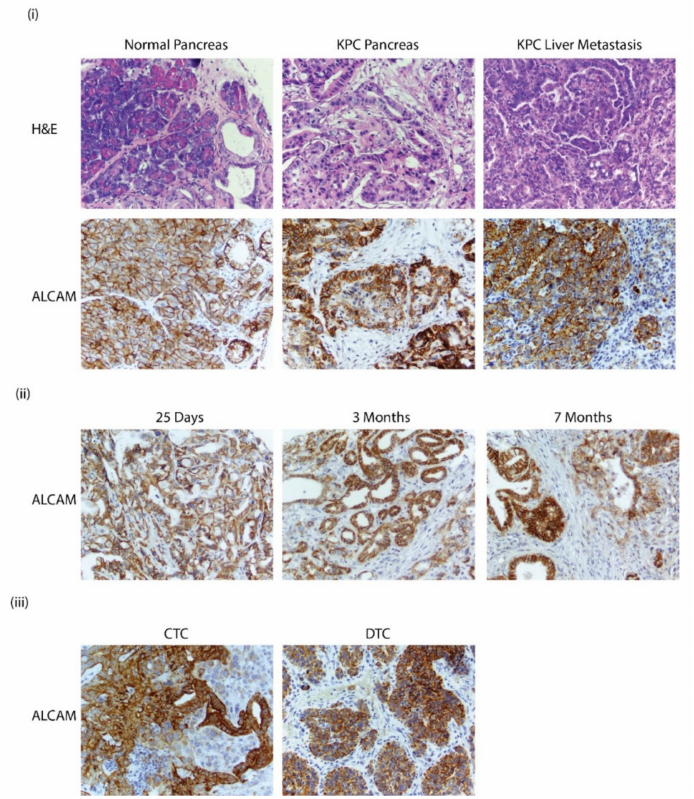
Figure 5. ( i ) H&E and Alcam staining of pancreas in C57BL6 and KPC GEMM mice with pancreatic cancer. Staining of liver metastasis in KPC GEMM mice (40 × magnification); ( ii ) Alcam staining in KPC GEMM pancreas collected from mice that were 25 days, 2 months, and 7 months; ( iii ) Alcam staining in circulating tumor cell (CTC) and dissociated tumor cell (DTC) that were propagated in subcutaneous models (40 ×